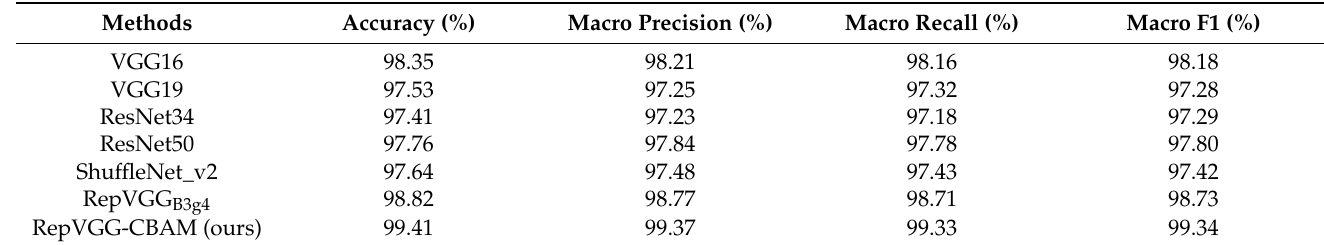
Table 7. Comparison results of different